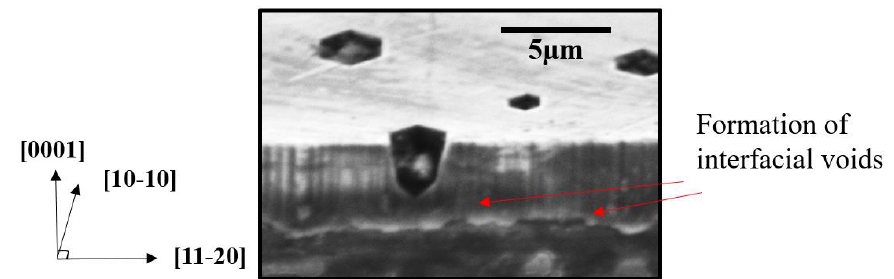
Figure 6. SEM image in bird’s-eye and cross-section view of sample D, depicting thin interfacial voids between GaN and sapphire.